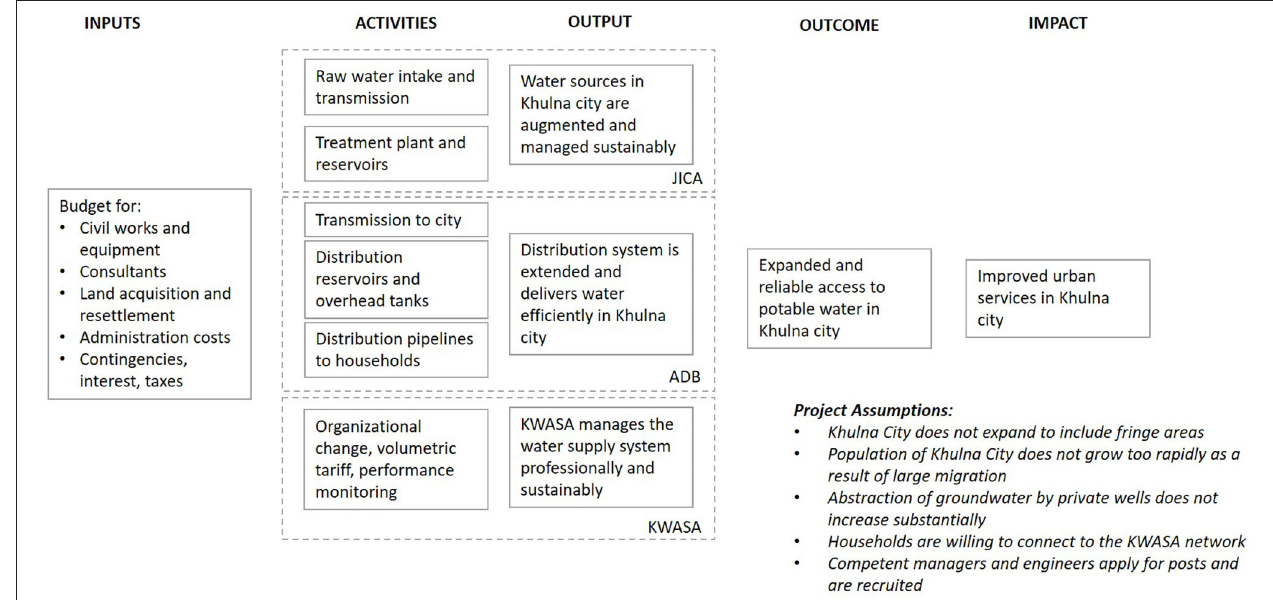
FIGURE 4 | Logic model for Khulna Water Supply Project.